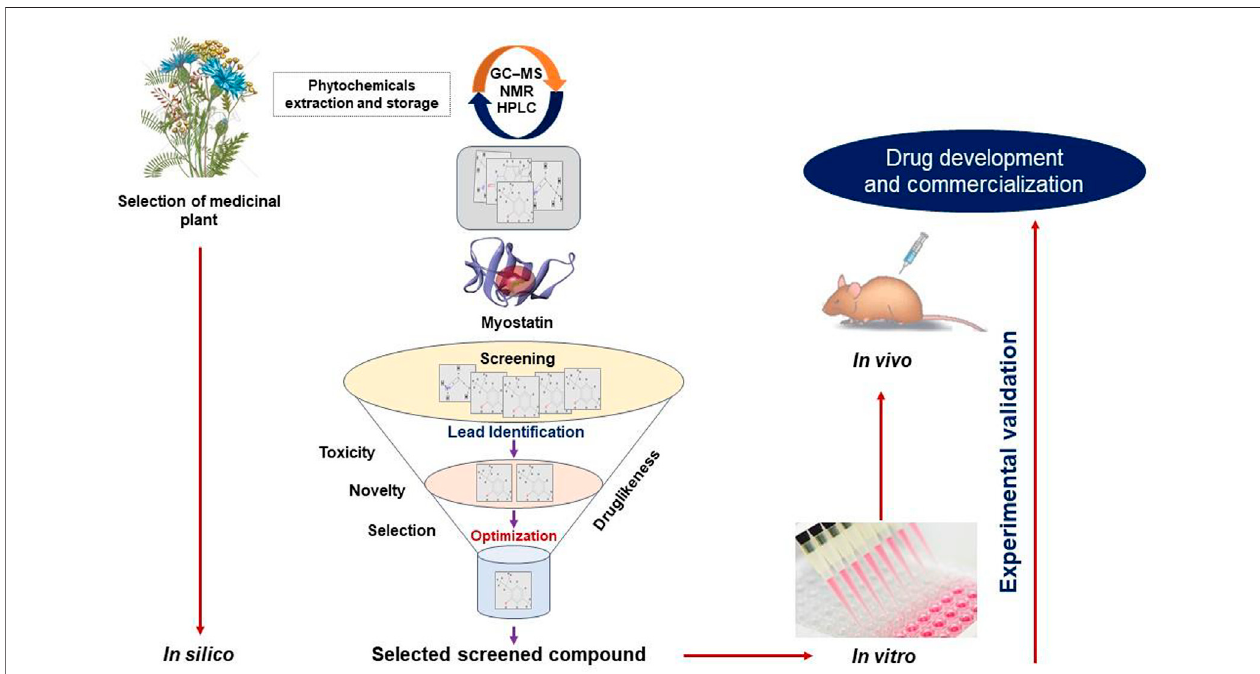
FIGURE 2 | A typical approach for the conventional drug design and development strategy. An overview of the techniques for identifying MSTN inhibitors using in silico (virtual screening, molecular docking, ADMET, and so on), in vitro , and in vivo approaches.